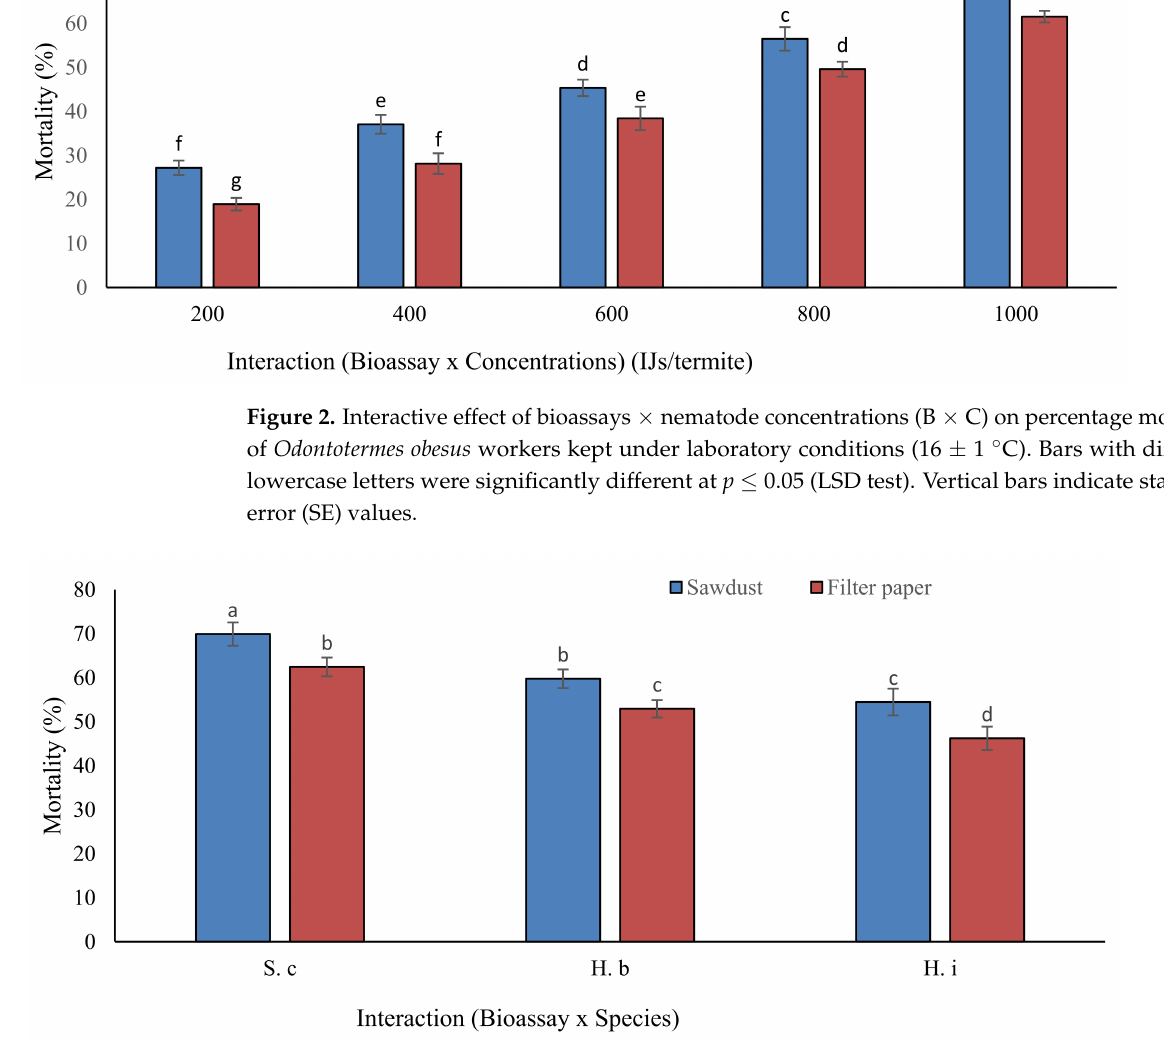
Figure 3. Interactive effect of bioassays × nematode species (B × S) on percentage mortality of Odon- totermes obesus workers kept under laboratory conditions (26 ± 1 ◦ C). Bars with different lowercase letters were significantly different at p ≤ 0.05 (LSD test). Vertical bars indicate standard error (SE) values. S. c: Steinernema carpocapsae; H. b: Heterorhabditis bacteriophora; and H. i: Heterorhabditis indica